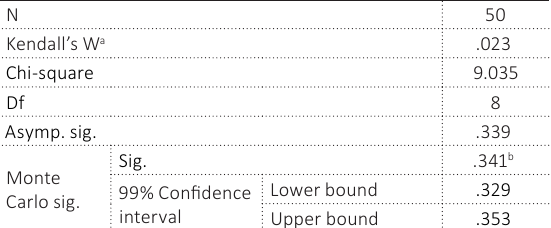
Table 7. Kendall’s W test